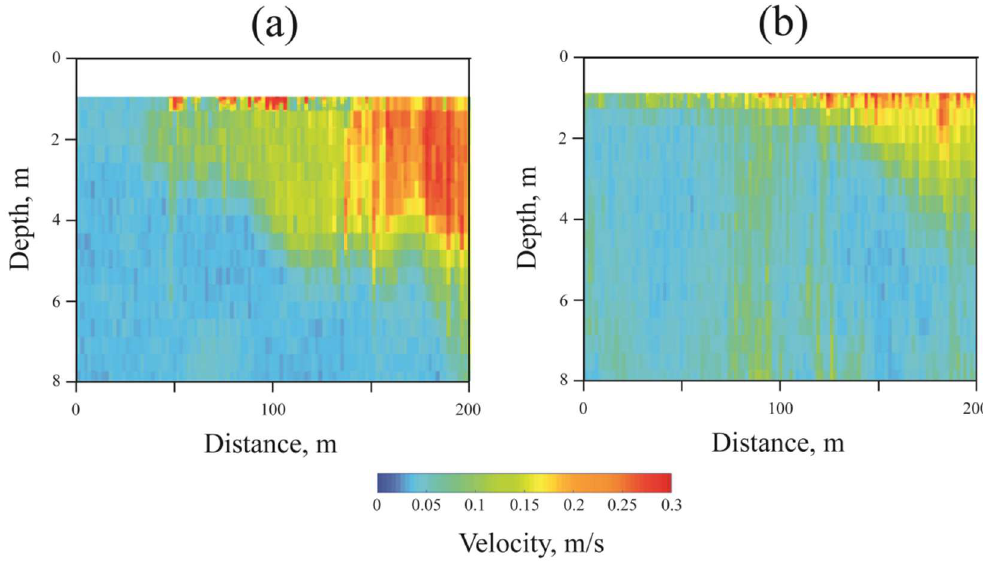
Figure 6. Absolute velocity structure across the near-field ( a ) and far-field ( b ) parts of the Kodor plume border on 3 April 2019.